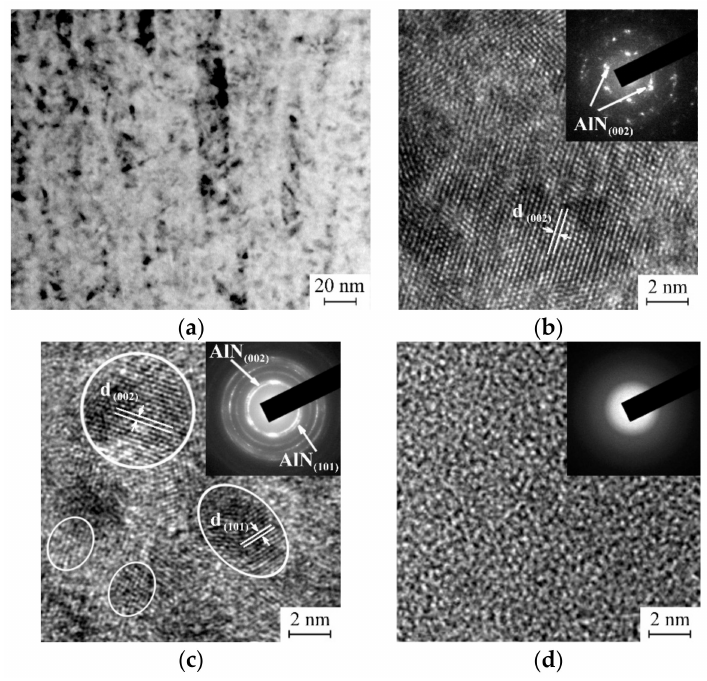
Figure 2. HRTEM micrographs and corresponding selected area electron di ff raction patterns (top right insets) of as-deposited Al 0.88 Si 0.12 N ( a , b ), Al 0.74 Si 0.26 N ( c ) and Al 0.11 Si 0.89 N ( d ) coatings. For clarity the nanocrystallites in ( c ) are outlined by white dashed contours.